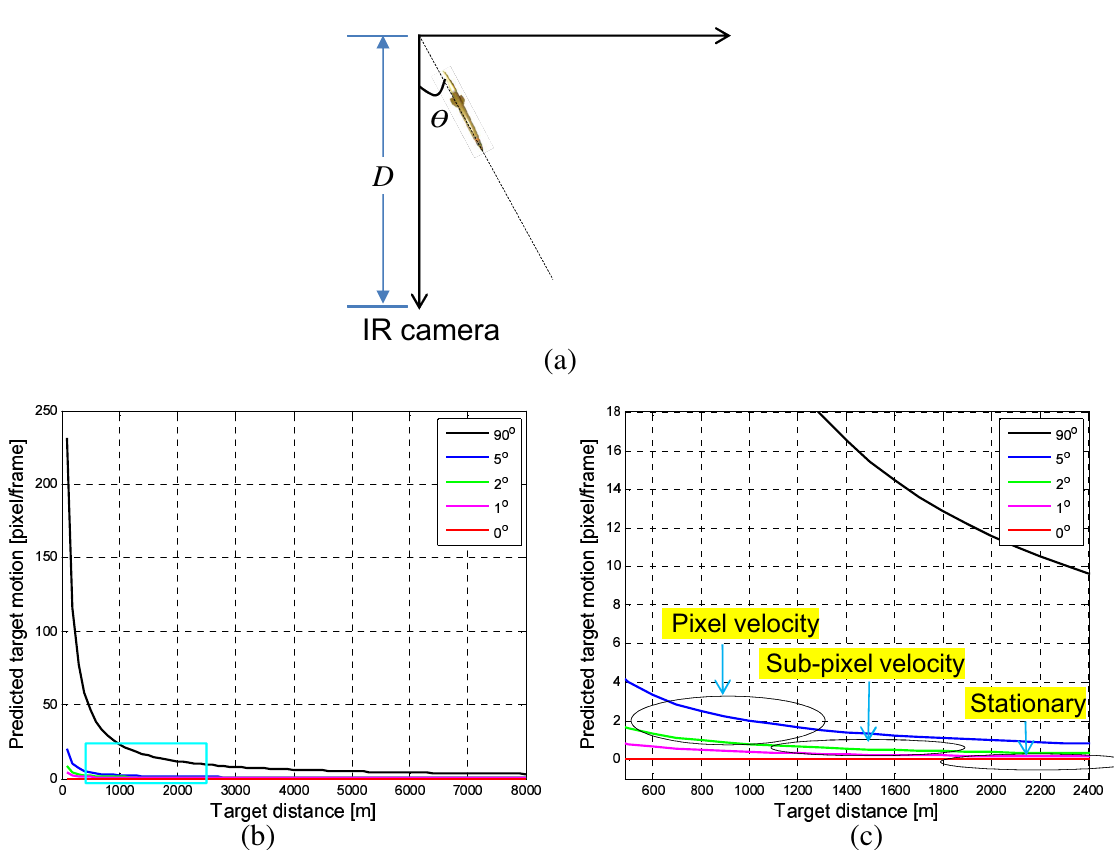
Figure 5. Analysis of imaged target motion depending on the incoming angle: ( a ) geometry of the incoming target (top-down view); ( b ) predicted target motion vs . the target distance ( D ); ( c ) enlarged